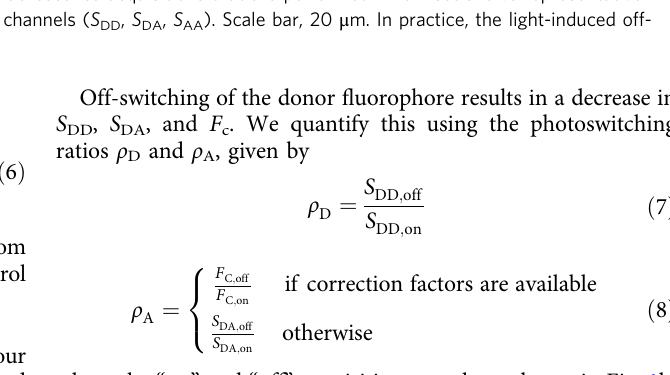
S S μ m. In practice, the light-induced off- DD , DA , AA ). Scale bar, 20